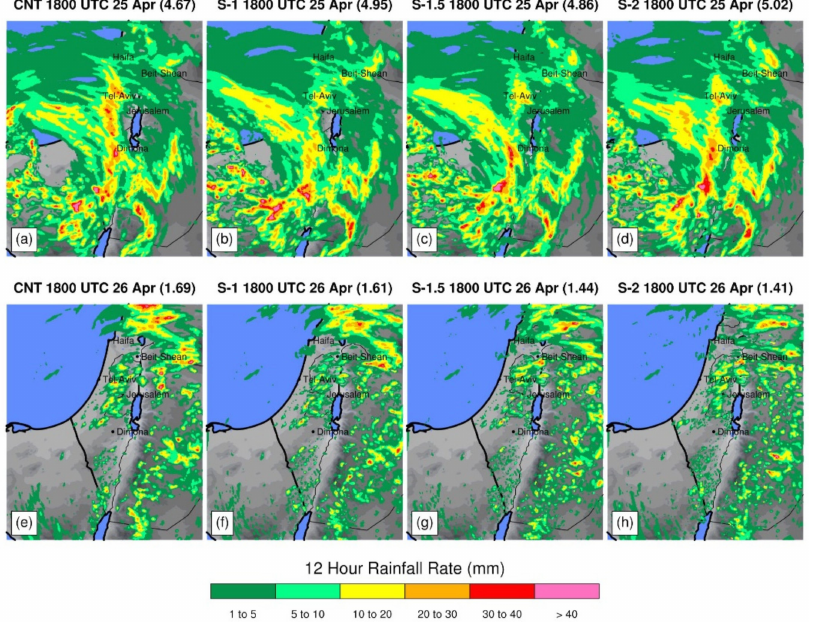
Figure 11. Simulated 12 h rainfall rates from simulations with soil moisture initialized from the Control ( a , e ), S-1.0 ( b , f ), S-1.5 ( c , g ), and S-2.0 ( d , h ) Area averages are given in the